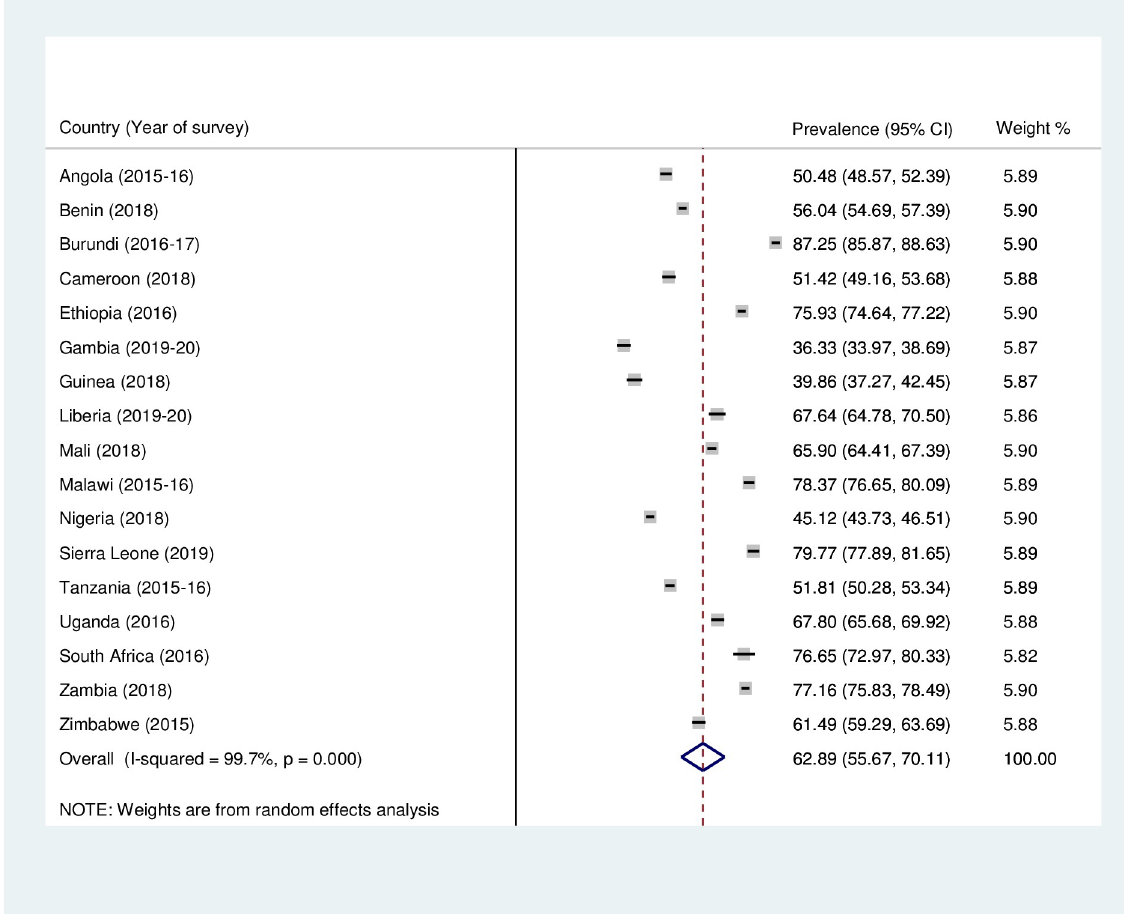
Fig 2. Forest plot showing the prevalence of timely initiation of breastfeeding in sub-Saharan